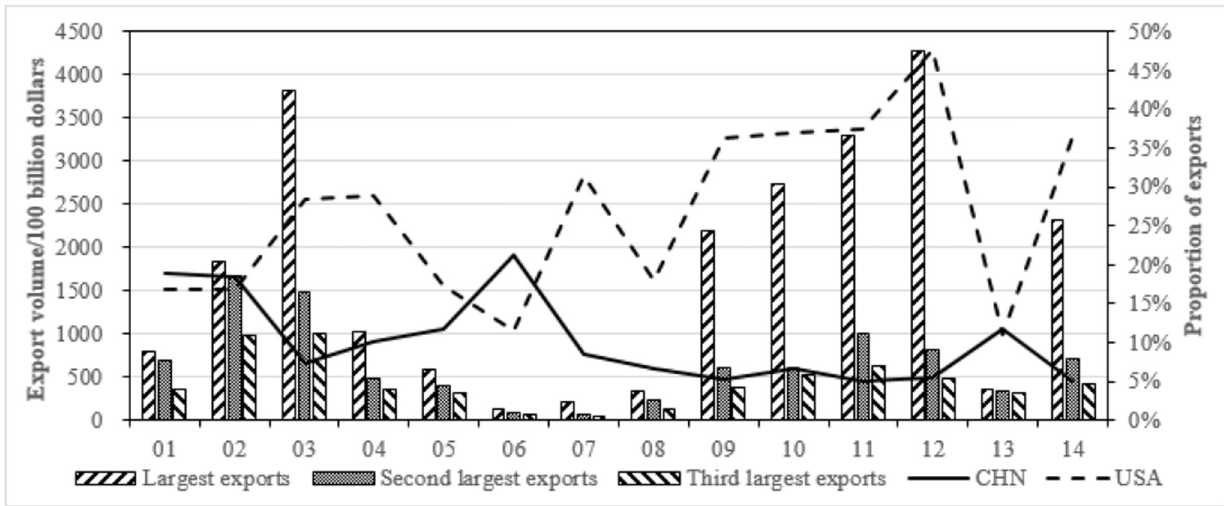
Fig 11. Top three exports of subdivided service industry and the proportions between China and the United States.